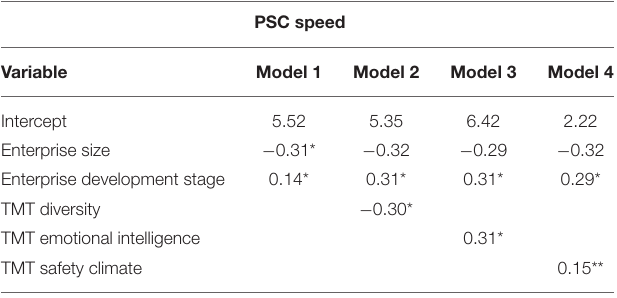
TABLE 5 | Regression analysis: Effects on firm